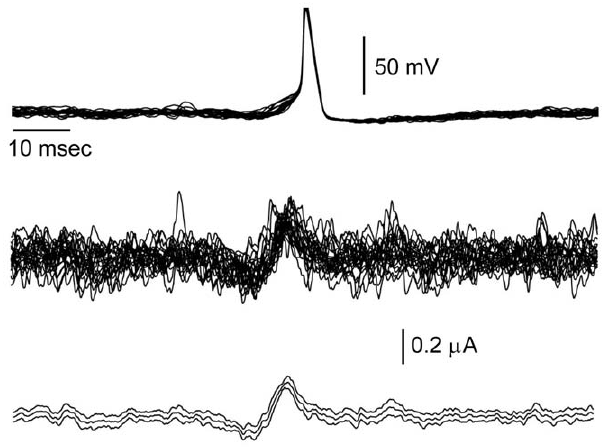
Figure 1. Spike triggered average from stochastic stimulation of squid giant axons. Squid giant axons were stimulated with our stochastic paradigm consisting of model EPSCs and IPSCs [1]. The recording from which this result was taken contained 21 spikes (record duration was 100 sec). All 21 spikes are shown superimposed in the top panel using the maximum amplitude of each spike as a reference point. The underlying current waveforms were similarly aligned (middle panel). The average of these results 6 2 SEM is shown in the bottom panel. This result is our candidate optimal stimulus waveform.